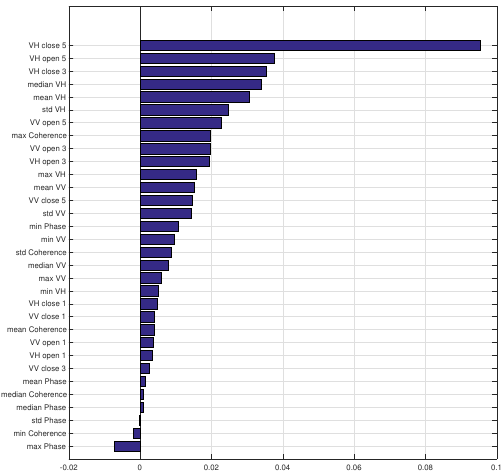
Figure 9. Feature importance obtained by CCF.